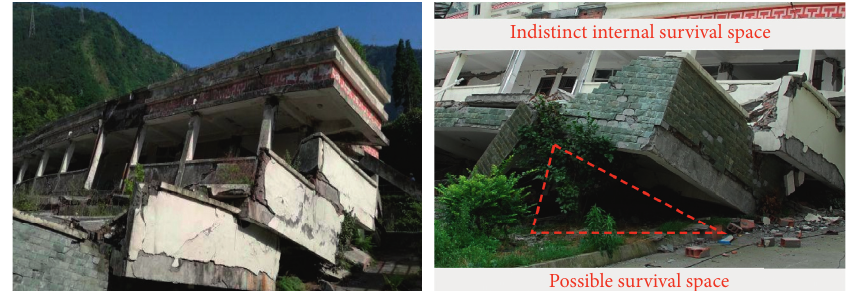
Figure 1: The final collapse state and possible survival space of the Xuankou middle school building (the pictures from author Dai Junwu).